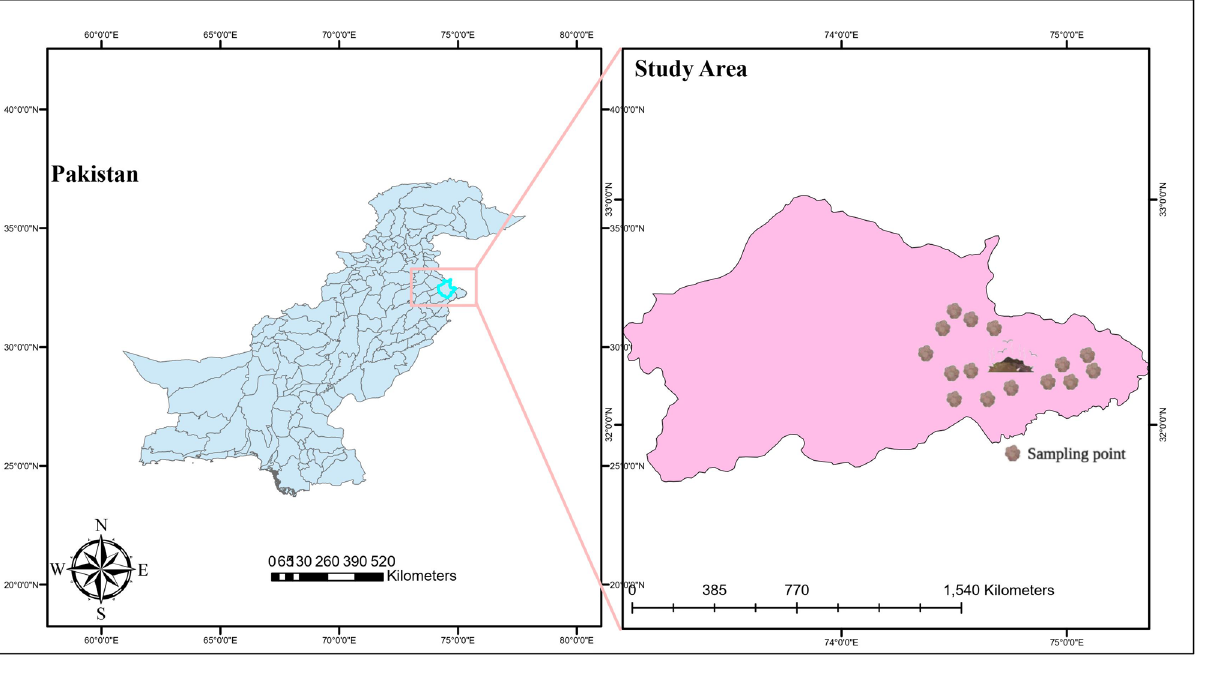
Figure 1. Study area. Thermo Fisher Scientific, iCAP 7400 with the radial viewed plasma equipped with echelle type 52.91 ICP-OES grooves/mm ruled grating RF power 1250